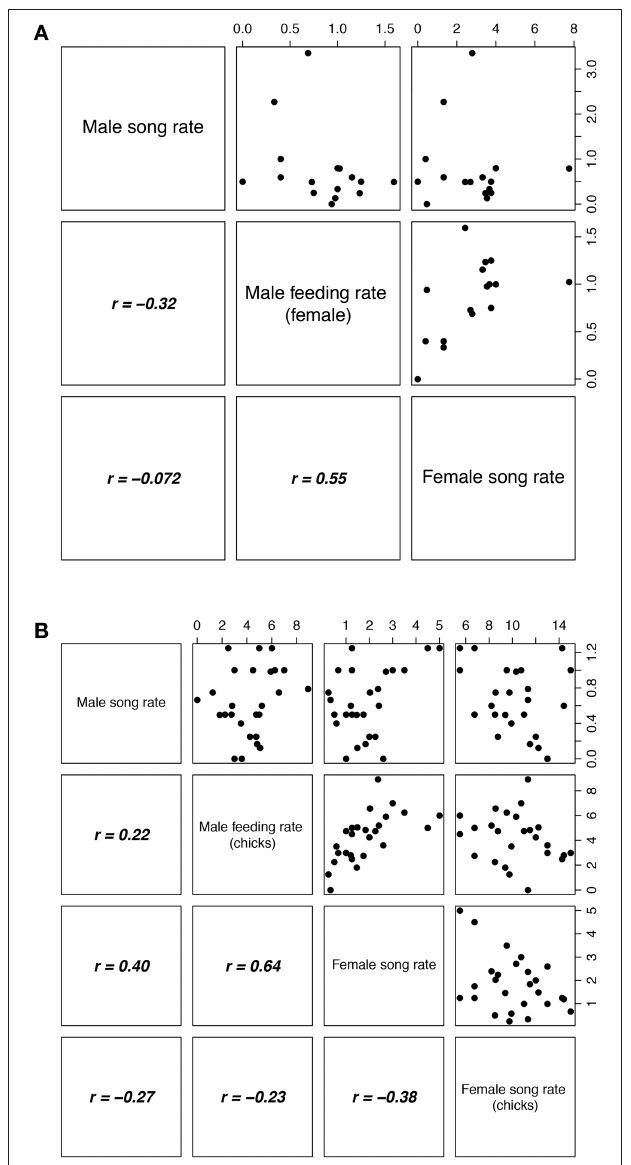
FIGURE 2 | Correlation matrix for behavioral parameters measured during (A) incubation and (B) chick-rearing stages. The four behavioral measures are on the diagonal, the upper triangle shows scatter plots, and the lower triangle shows the respective Pearson’s r -values. All values were measured as frequency per hour. Dataset based on means per nest (incubation, 16 nests; chick-rearing, 26 nests).